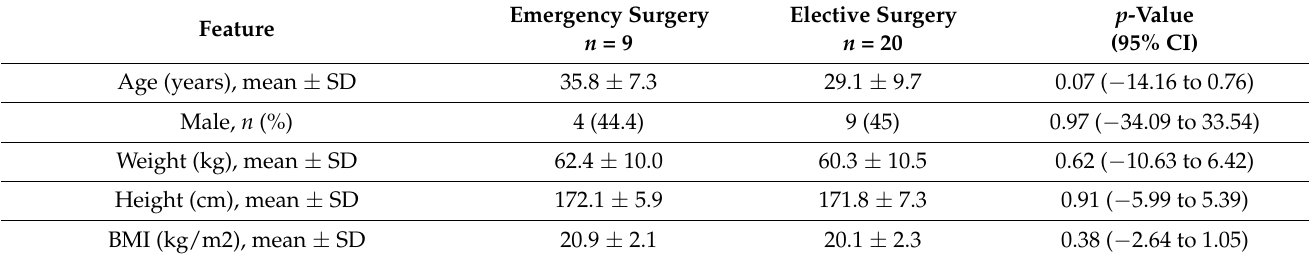
Table 2. Patient demographic data, operative, and radiation dose information, the excessive lifetime risk of all cancer, excessive lifetime risk for lung cancer, the baseline future risk for all cancer, and the total future risk (per